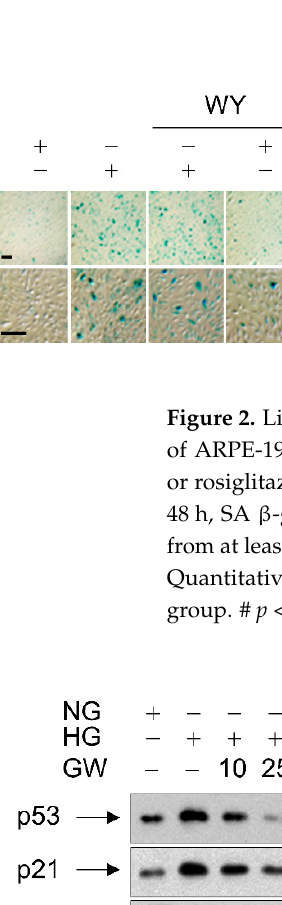
Figure 3. Ligand-activated PPAR δ regulates expression of the senescence-associated marker pro- teins p53, p21, and SMP-30 in ARPE-19 cells. ( A , B ) Cells pretreated with a vehicle (DMSO) or 10– 100 nM GW501516 (GW) for 24 h were exposed to NG (5.6 mM) or HG (30 mM). After incubation for 48 h, whole-cell lysates were prepared and subjected to Western blot analyses. Representative images from three independent experiments are shown ( A ) and quantitative data ( B ) are presented as means ± S.E. ( n = 3). * p < 0.01, ** p < 0.05 compared with the NG-treated group. # p < 0.01, ## p < 0.05 compared with the HG-treated group.